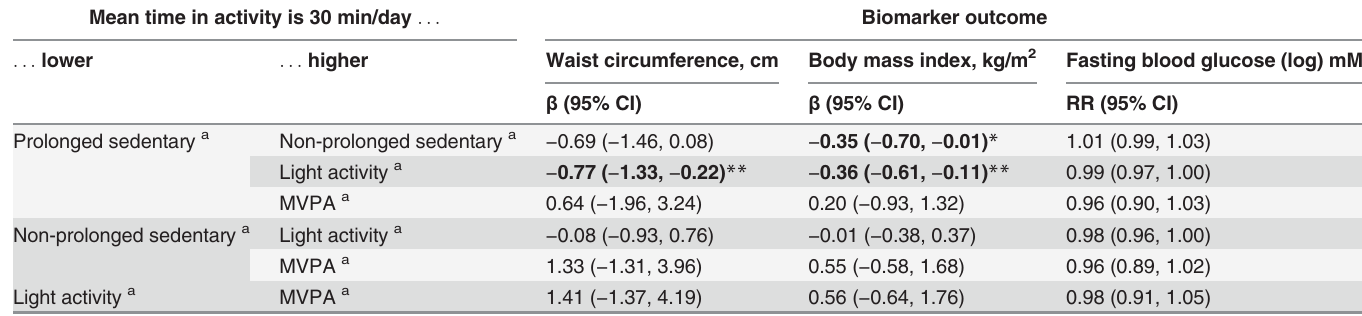
Table 3. Cross-sectional associations (Model 3) with waist circumference, BMI and fasting blood glucose in adults with type 2 diabetes and an overweight or obese BMI (n = 279) that were estimated for 30 minutes per day lower mean time spent in sedentary and light activity categories coupled with equivalent 30 minutes per day higher mean time spent in other activity categories. Mean time in activity is 30 min/day